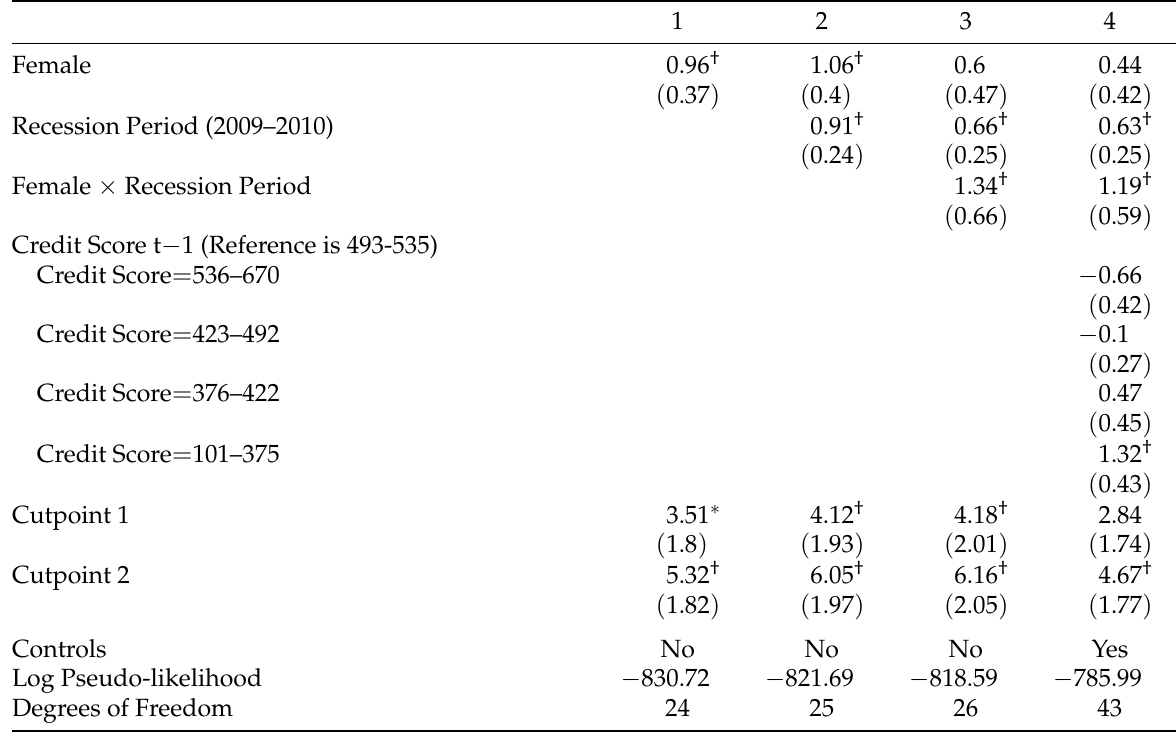
Table 3: Estimated Coefficients From Random Effects Ordered Logistic Regression Models Predicting